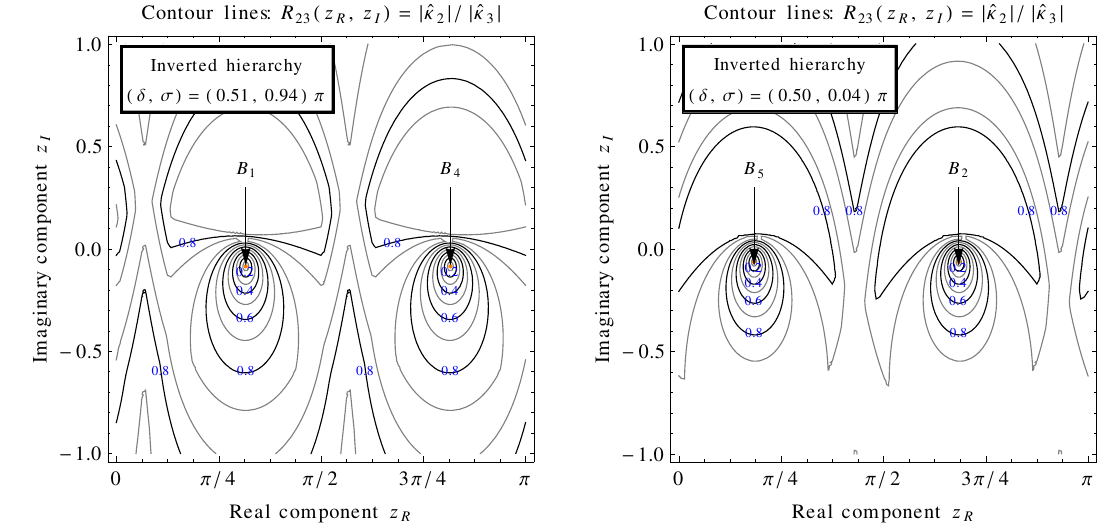
Figure 1 . Hierarchy parameter R 23 as a function of the complex parameter z after setting the phases (cid:14) and (cid:27) to their predicted values in the B 1 ; 4 (left panel) and B 2 ; 5 (right panel) scenarios, re- spectively (see eq. (2.18)). Notice that the values of z leading to exact two-zero textures correspond to zeros of R 23 in the complex z